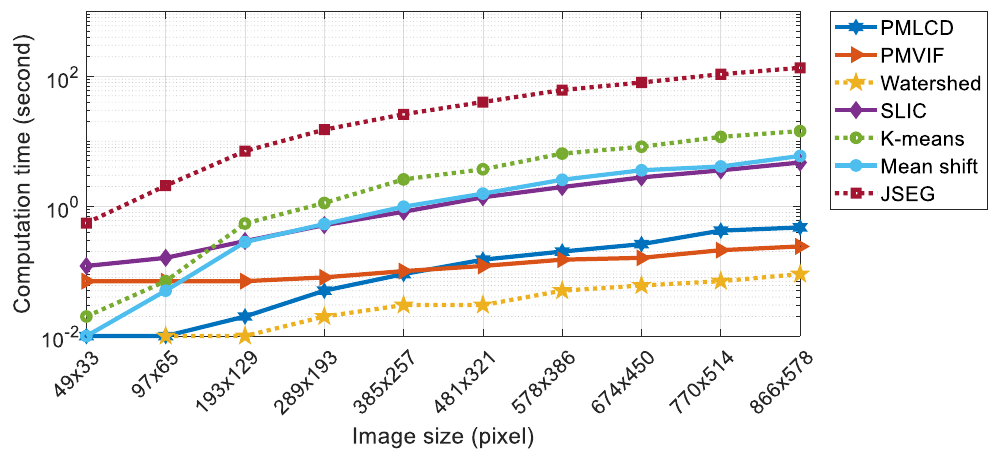
Figure 12. The comparison of the computation time of PMLCD and other methods.